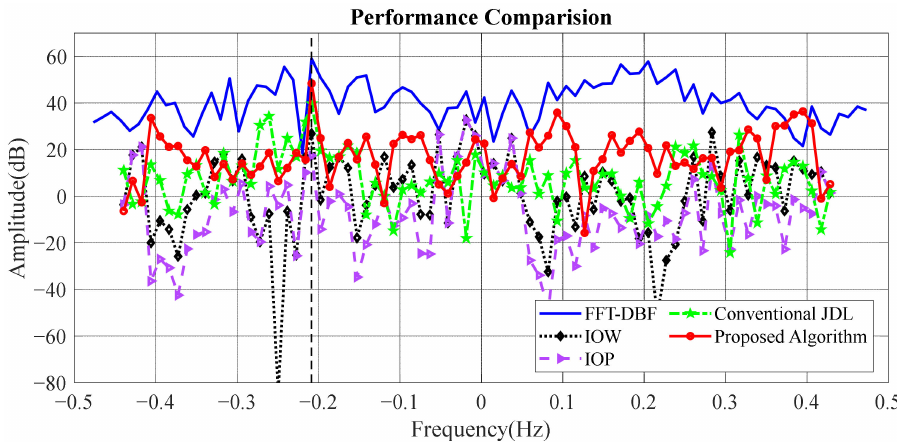
Figure 11. Comparison of Doppler profiles of the real target between different